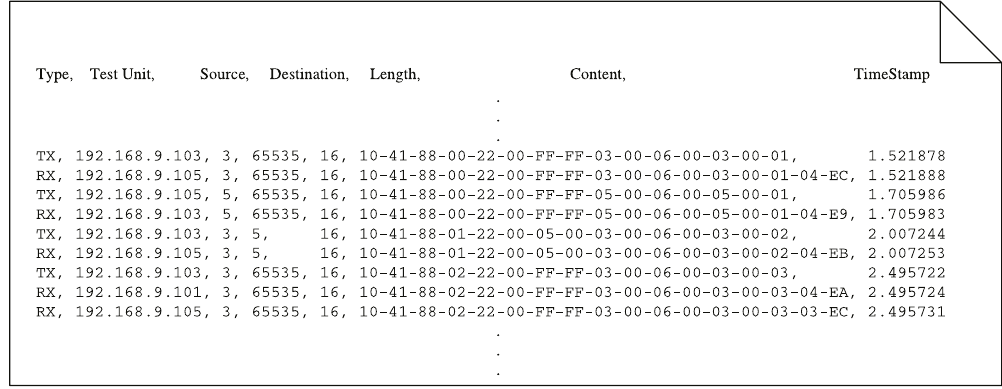
Figure 26: Trace file format of